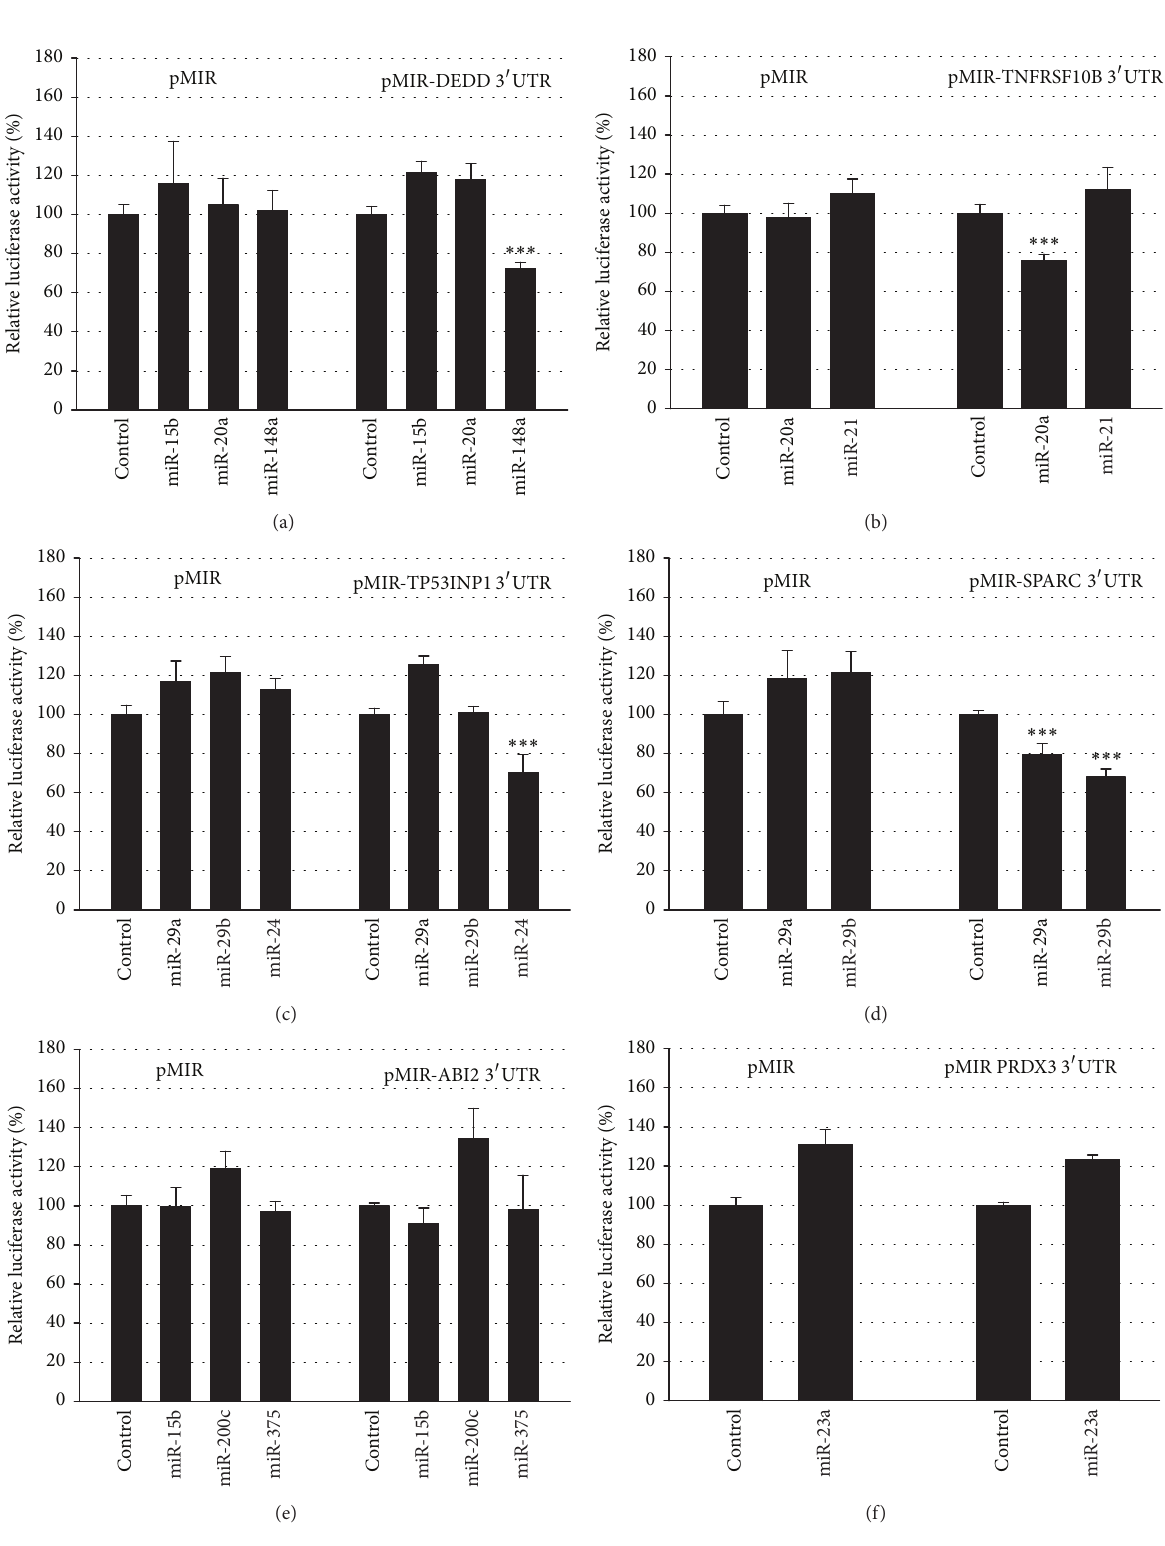
Figure 3: Response of 3 󸀠 UTRs towards miRNAs. The DEDD (a), TNFRSF10B (b), TP53INP1 (c), SPARC (d), ABI2 (e), and PRDX3 (f) 3 󸀠 UTRs were cloned behind the luciferase reporter gene of the pMIR vector. The reporter gene constructs were expressed with the miRNA expression construct or with the empty pSG5 vector in the indicated combinations. Results represent the mean of 4 independent experiments performed in duplicate. ∗∗∗ 𝑝 < 0.001